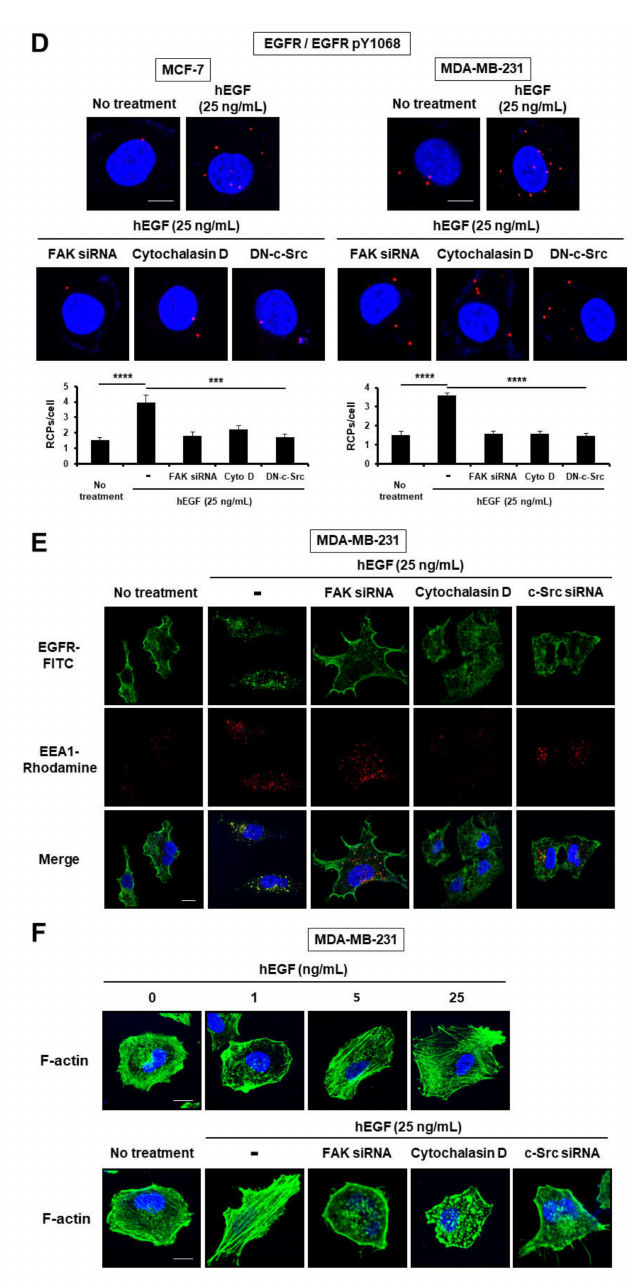
Figure 1. EGF induces EGFR dimerization and endocytosis through c-Src / FAK-mediated cytoskeleton reorganization. ( A , D ) The dimerization level of EGFR was assessed by in situ proximity ligation assay (PLA). ( B , C ) For dimerization assay, human breast carcinoma cells were treated with increasing concentrations of EGF in the presence or absence of cytochalasin D for 1 h on ice, to allow for EGF-induced EGFR dimerization but not endocytosis. Cells were subjected to BS 3 chemical-mediated crosslinking as described in Materials and Methods. To determine the phosphorylation level of EGFR at Y1068, cells were incubated in serum-free medium (SFM) with EGF for 15 min at 37 ◦ C. Cell extracts were assessed by Western blot analysis with the indicated antibodies. β -actin was used as a loading control. ** p < 0.01; *** p < 0.001; **** p < 0.0001. ( E , F ) EGFR endocytosis and actin cytoskeleton organization were determined by immunofluorescent assay (IFA). ( A , D , E , F ) Original magnification of representative images, 600 × . Scale bars = 10 µ